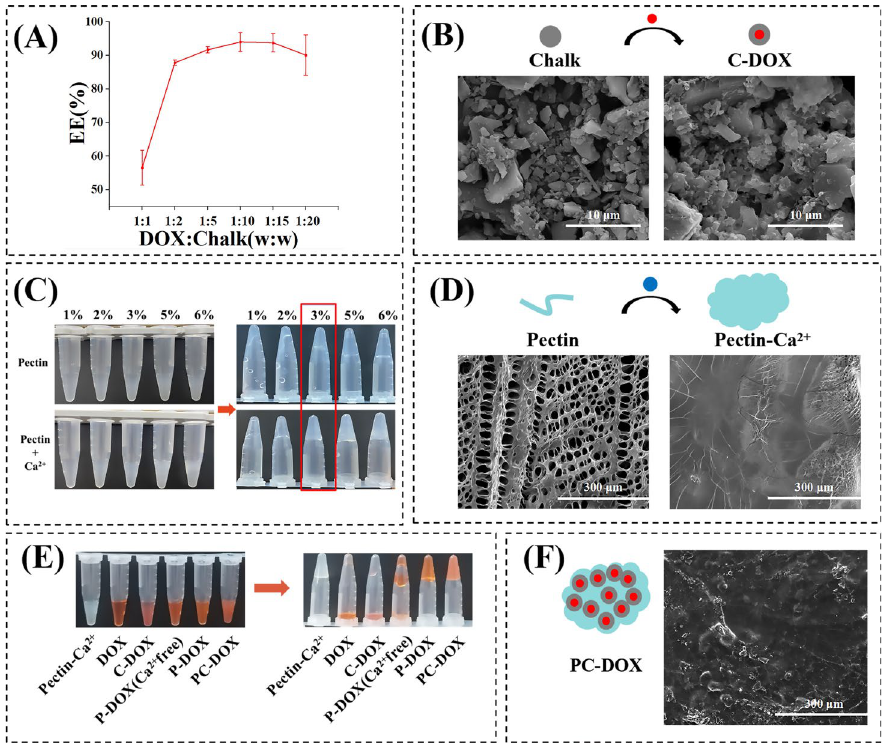
Figure 1. Preparation and characterization of pectin-chalk DOX gels ( PC−DOX ). ( A ) The encapsula- tion efficiency of DOX; ( B ) SEM of chalk and C−DOX ; ( C ) different concentrations of pectin and pectin-Ca 2+ gels; ( D ) SEM of pectin and pectin-Ca 2+ gels; ( E ) all control and experimental groups of PC−DOX ; ( F ) SEM of PC−DOX .